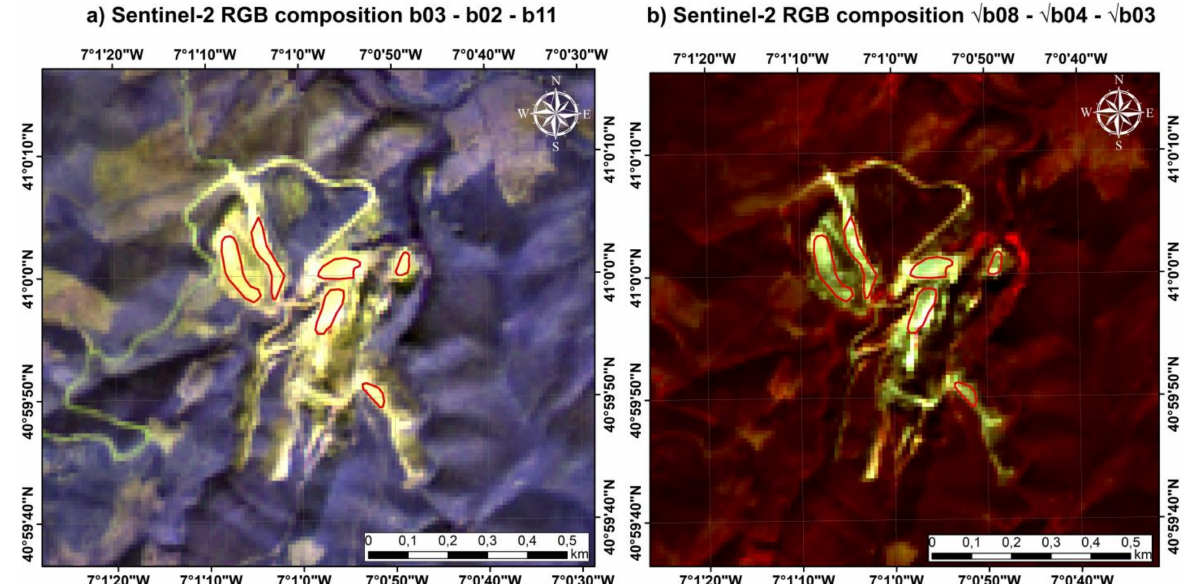
Figure 3. Training patterns (red outlines) with different RGB compositions in the background: ( a ) Sentinel-2 RGB composi- tion b03–b02–b11, ( b ) Sentinel-2 RGB composition respectively, correspond to areas hosting Li mineralisation exposed on the ground